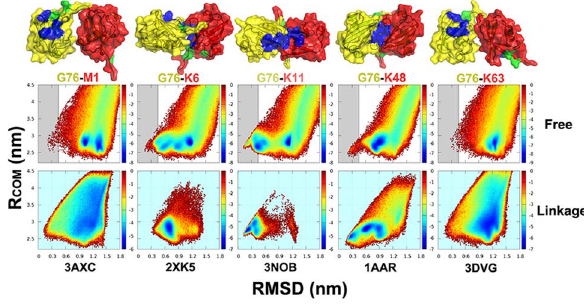
Figure 2. Compact conformations of diUbs preexist on the binding landscape of free Ubs. The free energy surfaces as a function of the distance between the center of mass of Ub monomers ( R COM ) and RMSDs from the compact structures (PDB 3AXC, 2XK5, 3NOB, 1AAR and 3DVG) of five linkage types resolved by X-ray crystallography and NMR (M1, K6, K11, K48 and K63, listed in Table 1 in Text S1). The native conformational regions are labelled by grey in the free Ub model. Note that the same conformational space sampled by the free Ub model at given concentrations (5 mM here) was used. For comparison, the results of corresponding linkage models (CGM1, CGK6, CGK11, CGK48 and CGK63 models, see Table 2 in Text S1) are also plotted below. The compact structures of these linkage types are shown above with the distal Ub unit in yellow and the proximal Ub unit in red. The two hydrophobic patches, I36 and I44, are colored in green and blue, respectively.